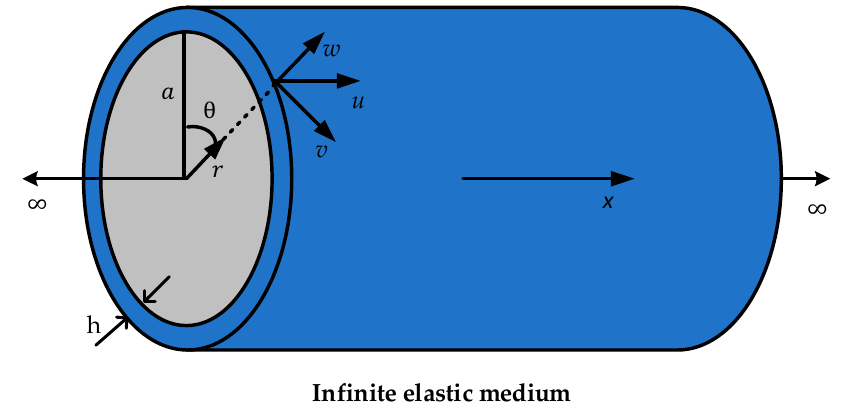
Figure 1. The coordinate system for a fluid-filled pipe in an infinite elastic medium.